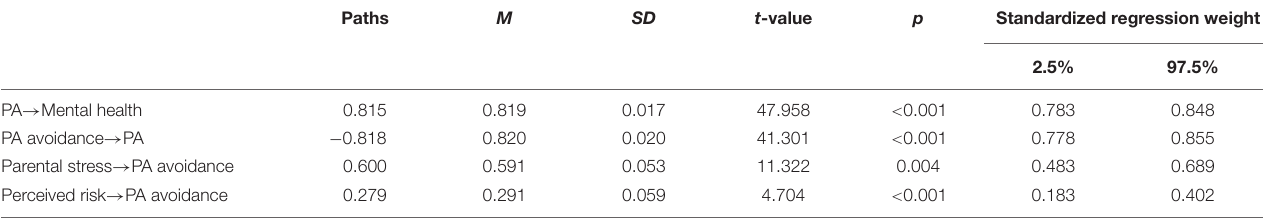
TABLE 5 | Standardized regression weights (along with the 95% confidence interval). Paths M SD p Standardized regression weight